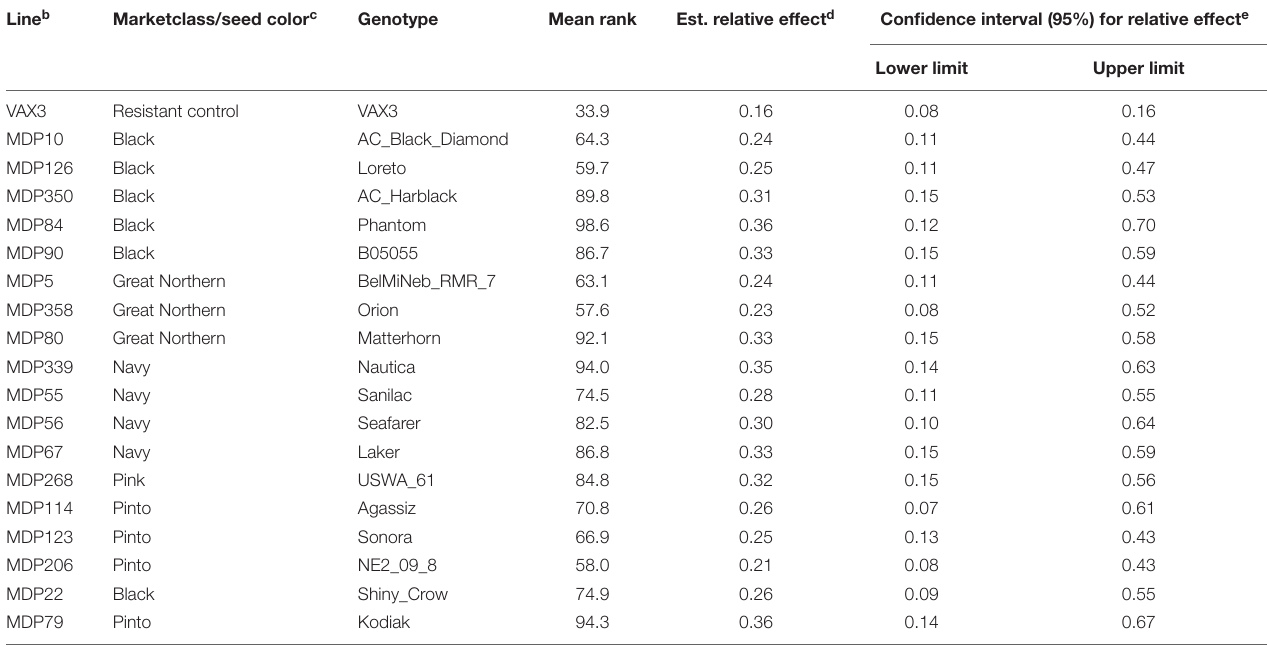
TABLE 3 | Summary of phenotypic data for bean lines within the Middle American Diversity Panel (MDP) statistically similar to the resistant control VAX3. Overlapping confidence intervals and p- values ( α < 0.05) a were used to determine statistical similarity between bean lines and the resistant control (VAX3). Line b